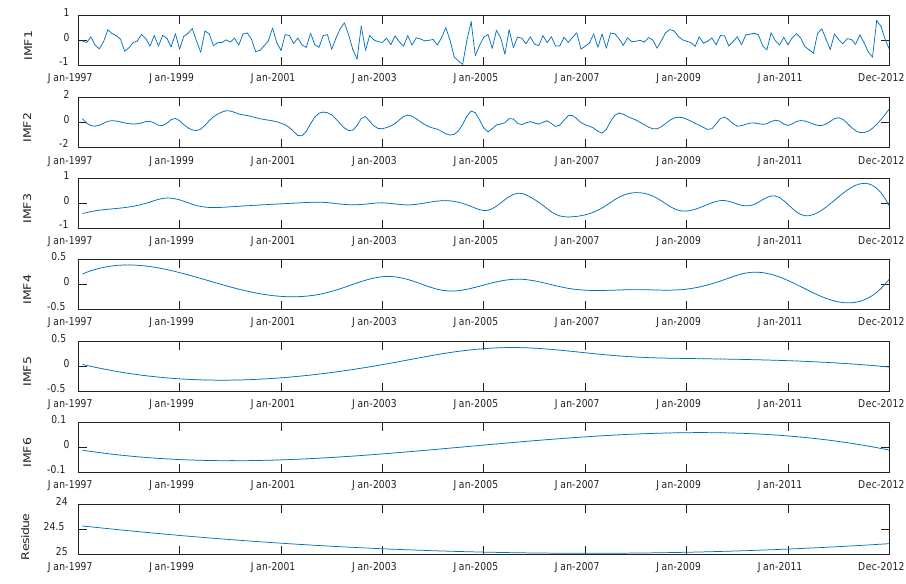
Figure 9. Decomposition of groundwater level time-series at the M1255 observation well.